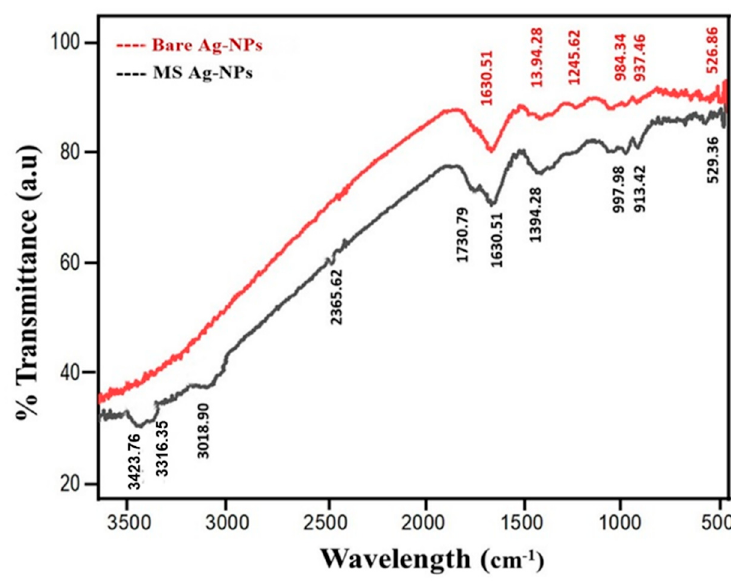
Figure 3. FTIR pattern of the bare AgNPs (red spectra) and MS-AgNPs (black spectra).